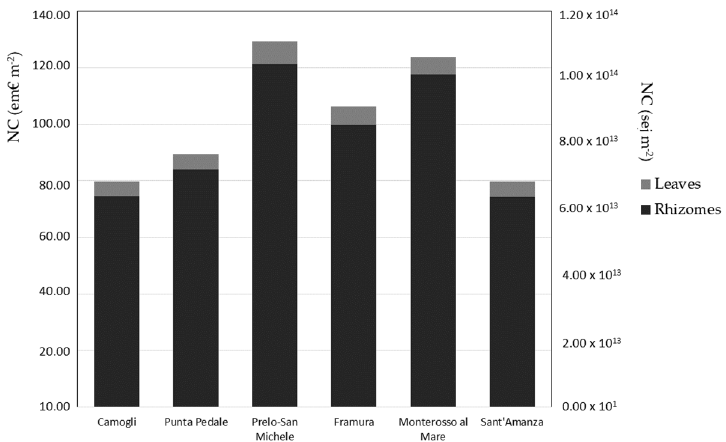
Figure 2. Natural Capital (NC) stocked by the leaves and rhizomes components of P. oceanica , expressed as sej · m − 2 and em € · m − 2 , in the meadows investigated.